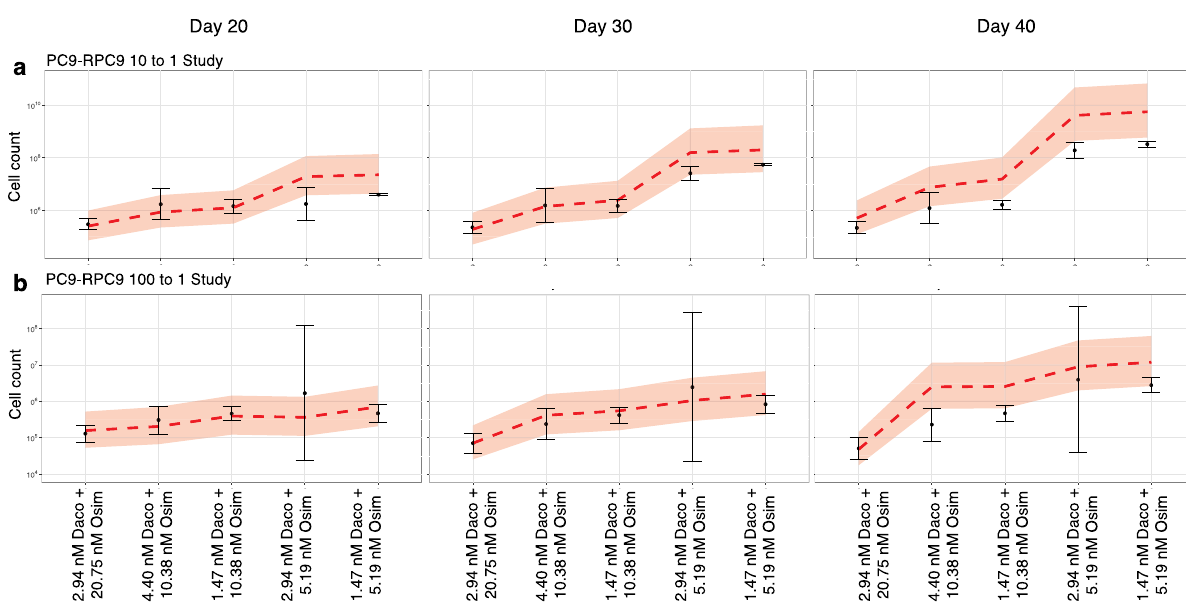
Fig. 4 Longitudinal validation experiments in mixed cell pools at days 20, 30, and 40 of treatment. Predictions and interquartile ranges from mathematical modeling predictions are shown in a dashed red line and shaded regions, respectively. Observations with two standard errors are shown in black dots and error bars, respectively. The RPC9 (RPC9-CL6) clone is composed of 90% exon 19 del cells 10% exon 19 del and T790M alleles. a PC9- RPC9 cell pool in 10 – 1 ratio. Our predictions ranked schedules correctly, detecting a difference between the two best schedules at day 30 ( p = 0.0159, two- sided t -test with n = 6 biological samples). b PC9-RPC9 cell pool in 100 – 1 ratio. Our predictions ranked schedules correctly except for the worst 2 schedules, but the difference between the schedules was not statistically signi fi cant in the observed data ( p = 0.294, two-sided t -test with n = 6 biological samples). Source data are provided as a Source Data fi le.